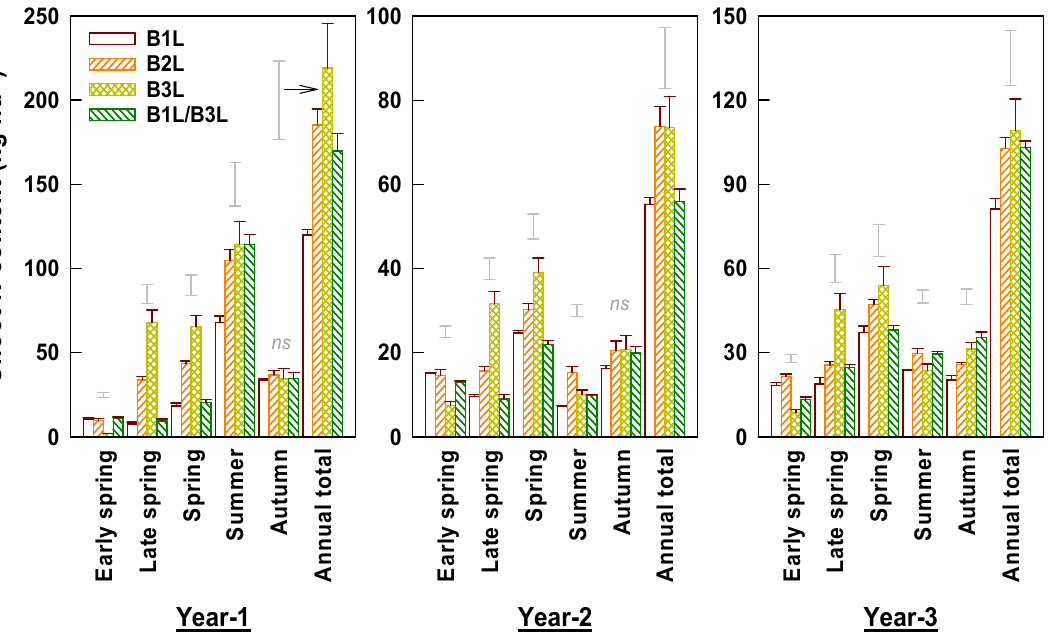
Figure 6. Contents of nitrogen in young shoots harvested under different standards in early and late spring, summer, and autumn over three experimental years (means ± standard errors, n = 4). Single bars without data points located above columns are LSD values indicative of significant ( p < 0.05) differences between harvest standards in the specified season. The symbol ‘ ns ’ above columns indicates no significant difference between four harvest standards.